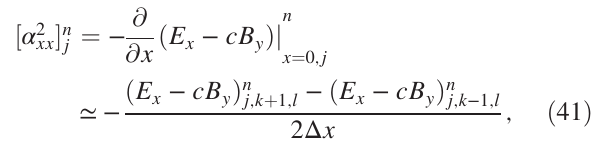
FIG. 4. Fields taken from the 3D simulation at ω the z − x plane at y ¼ 0 . (left) Accelerating ( E focusing ( E ) x